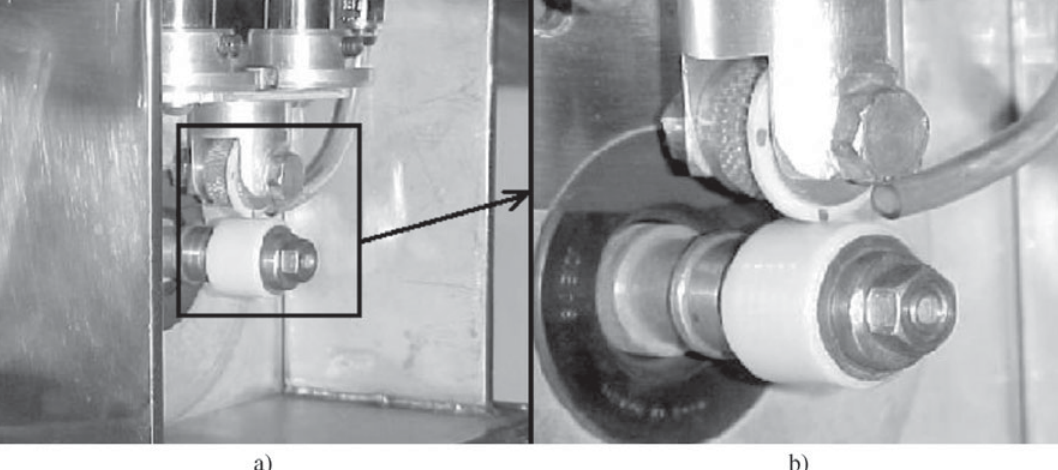
Figura 3. Fotografia com o posicionamento dos discos estático e dinâmico no conjunto banco de ensaios/cabeçote de testes (a); detalhe (b) mostra o contato da resina presente no disco estático (superior) com a cerâmica do disco dinâmico (inferior).